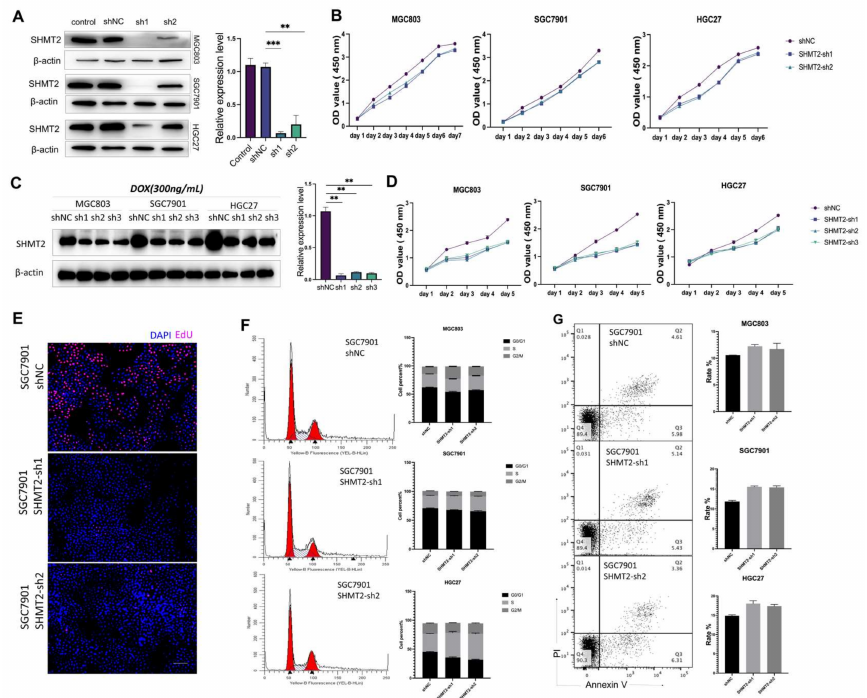
Figure 2. Inhibition of SHMT2 suppressed GC cell proliferation and induced apoptosis. ( A ) West- ern blot and real-time PCR identified the knockdown efficiency of SHMT2 in MGC803, SGC7901, and HGC27. ( B ) CCK-8 assay was performed to evaluate the proliferation of MGC803, SGC7901, and HGC27 cells after transfection with shSHMT2. ( C ) Western blot and real-time PCR confirmed the SHMT2 knockdown efficiency in MGC803, SGC7901, and HGC27 with doxycycline (DOX) (300 ng/mL) induction. ( D ) CCK-8 assay measured the proliferation of shSHMT2 MGC803, SGC7901, and HGC27 cells after DOX (300 ng/mL) induction. ( E ) EdU assay detected the effect of the prolif- eration of shSHMT2 MGC803, SGC7901, and HGC27 cells. Scale bar, 100 µ m. ( F ) Effect of SHMT2 knockdown on the cell cycle of MGC803, SGC7901, and HGC27 cells. ( G ) Effect of SHMT2 knockdown on apoptosis in MGC803, SGC7901, and HGC27 cells (Q2 + Q3). ** p < 0.01, *** p <